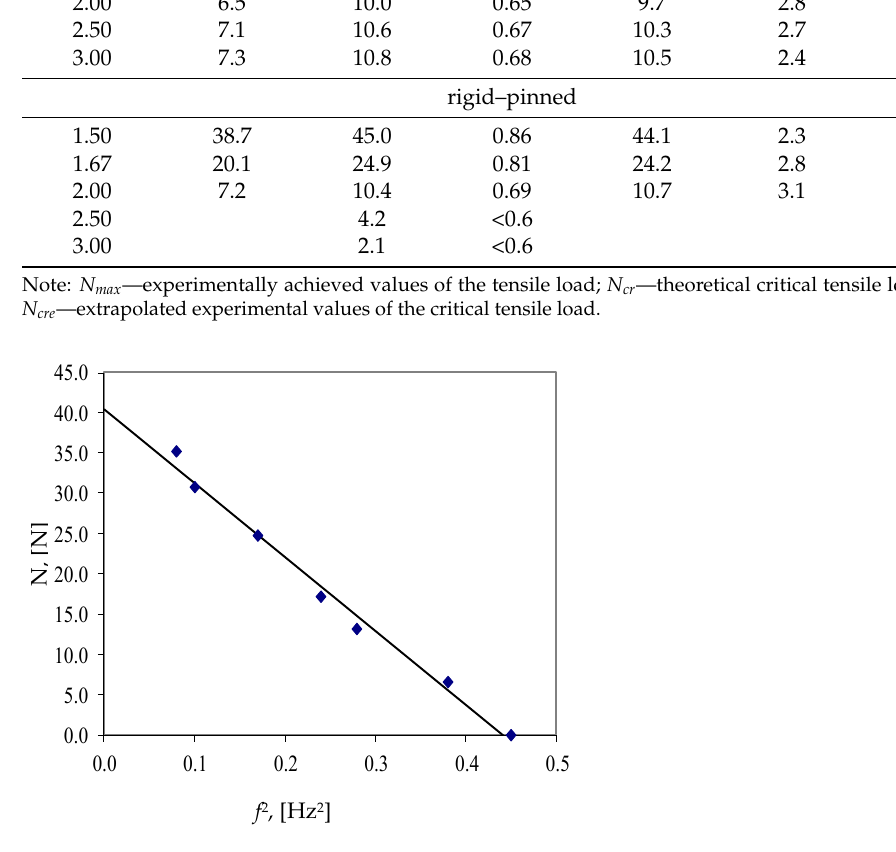
Figure 12. Dependence of the squared natural vibration frequency on load N for L/R = 1.5 and rigid–rigid end connections.